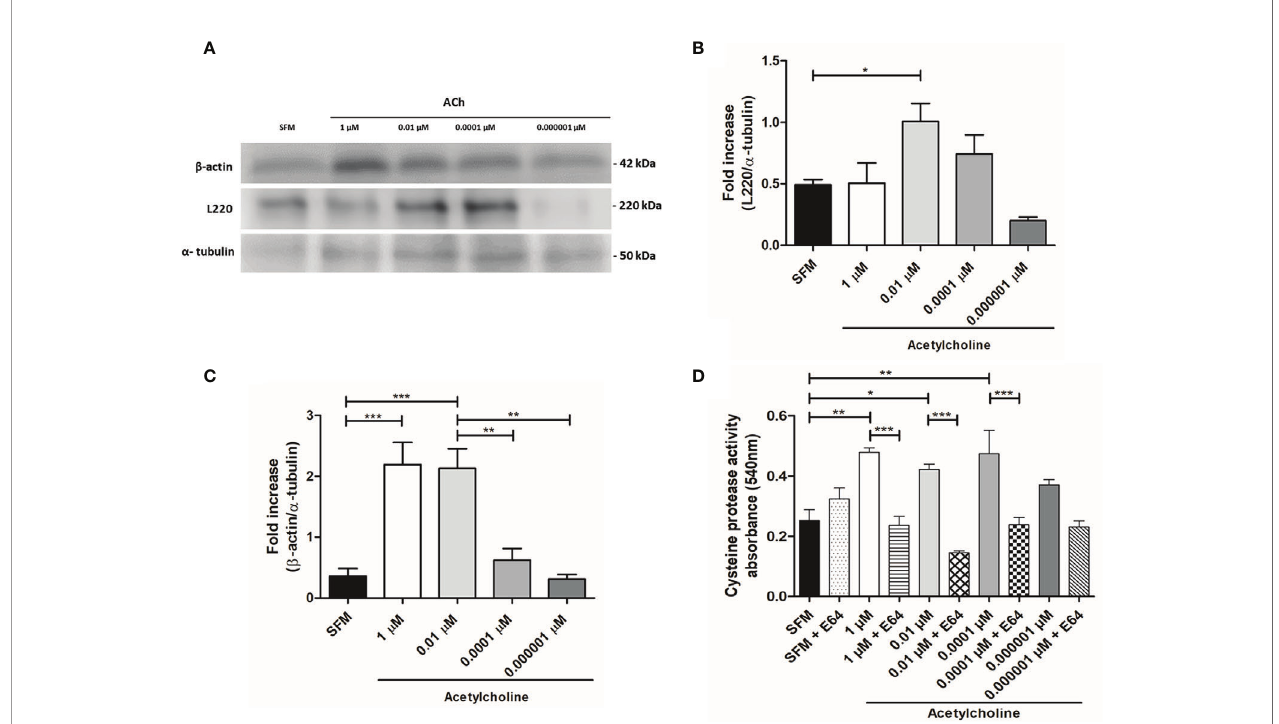
FIGURE 4 | Expression of b -actin and L220 analyzed by western blot, and cysteine protease activity evaluation in ACh-treated trophozoites. (A) Immunodetection from total lysates of trophozoites treated with different concentration of ACh for 1 h, using anti- b -actin, anti-L220 and anti- a -tubulin antibodies in Western blot assays. (B) Densitometric analysis L220 and (C) b -actin using ImageJ software. Protein levels were normalized to a -tubulin. (D) Intracellular cysteine protease activity assessed by a spectrophotometric azo-collagen assay. Total extracts of ACh-stimulated trophozoites in the presence or absence of E-64 (a cysteine protease inhibitor). Data correspond to the mean ± SEM of three independent experiments (n = 3). The statistical analysis was performed with the one-way ANOVA and Tukey or Dunnett ’ s posttest method, where the values of *p < 0.05, **p < 0.01 and ***p < 0.001 were considered signi fi